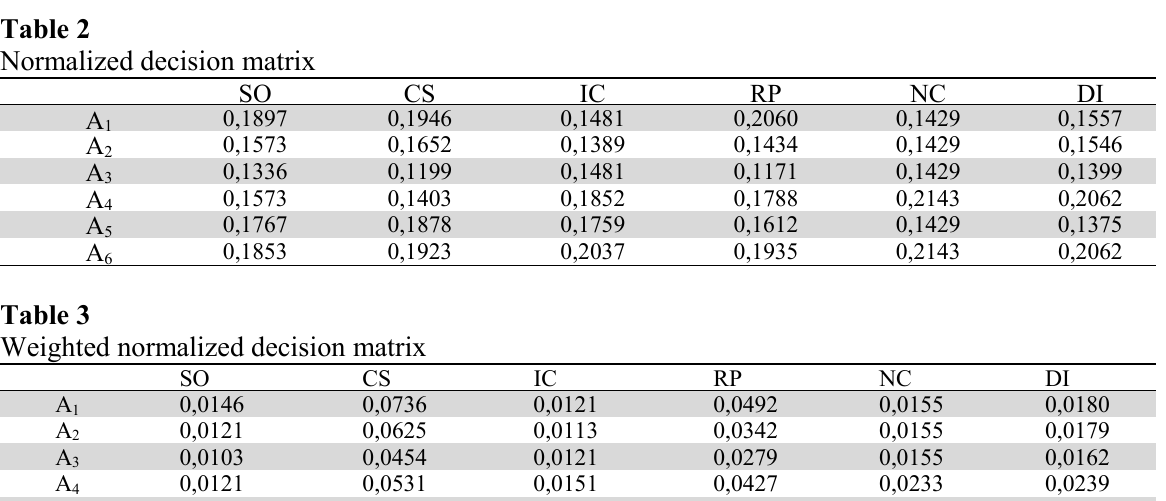
Normalized decision matrix